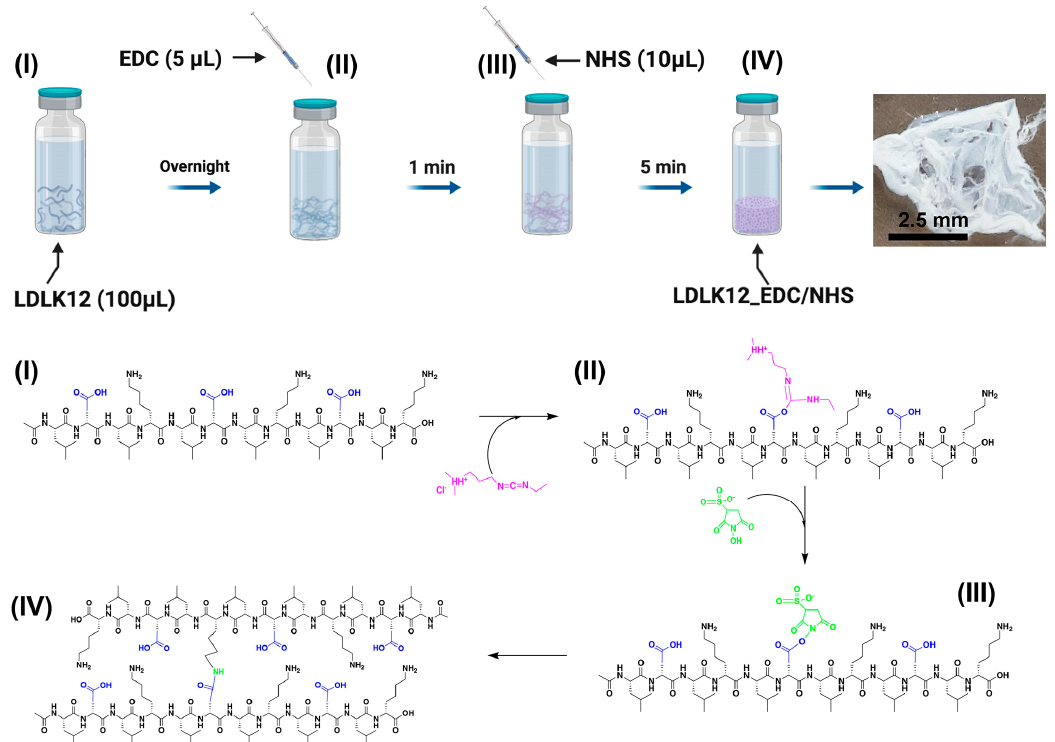
Figure 1. EDC / sulfo–NHS (1-ethyl-3-[3-dimethylaminopropyl] carbodiimide / N -hydroxysulfosuccinimide) Figure 1. EDC/sulfo–NHS (1-ethyl-3-[3-dimethylaminopropyl] carbodiimide/ N - cross-linking reaction. Schematic illustration and chemical reaction of the one-pot and in situ hydroxysulfosuccinimide) cross-linking reaction. Schematic illustration and chemical reaction of the LDLK12 (Ac-LDLKLDLKLDLK-CONH 2 ) cross-linking based on EDC / sulfo–NHS coupling: ( I ) LDLK12, one-pot and in situ LDLK12 (Ac-LDLKLDLKLDLK-CONH 2 ) cross-linking based on EDC/sulfo–NHS ( II ) O-acylisourea intermediate LDLK12 peptide, ( III ) sulfo–NHS-modified LDLK12 peptide, coupling: ( I ) LDLK12, ( II ) O-acylisourea intermediate LDLK12 peptide, ( III ) sulfo–NHS-modified and ( IV ) EDC / sulfo–NHS cross-linked LDLK12 peptides. In the schematic representation of the LDLK12 peptide, and ( IV ) EDC/sulfo–NHS cross-linked LDLK12 peptides. In the schematic amide bond formation, the LDLK12 peptide is shown in black, the carboxyl group is shown in blue, representation of the amide bond formation, the LDLK12 peptide is shown in black, the carboxyl EDC is shown in magenta, and sulfo–NHS is shown in light group is shown in blue, EDC is shown in magenta, and sulfo–NHS is shown in light green.